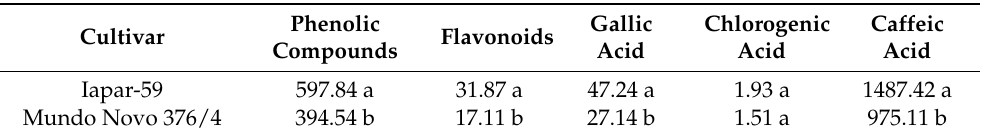
Table 1. Contents of total phenolic compounds (mg GA g − 1 extract), flavonoids (mg Q g − 1